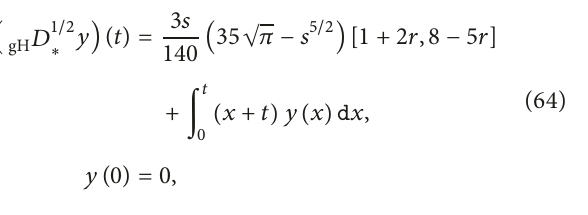
Figure 1: The level sets of 𝑦(𝑡) (a) and gH 𝐷